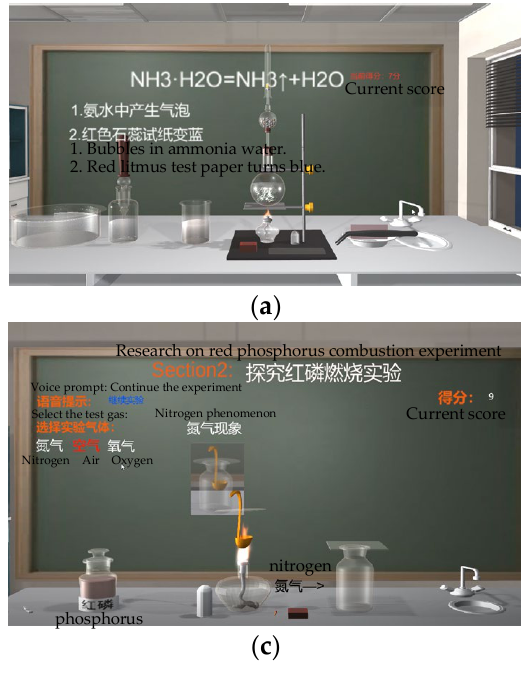
Figure 15. Specific experimental process diagram. ( a ). The experiment of ammonia preparation. ( b ). The experiment of investigating the properties of burning charcoal. ( c ). The experiment of investigating the combustion of red phosphorus. ( d ). The experiment of investigating the properties of concentrated sulfuric